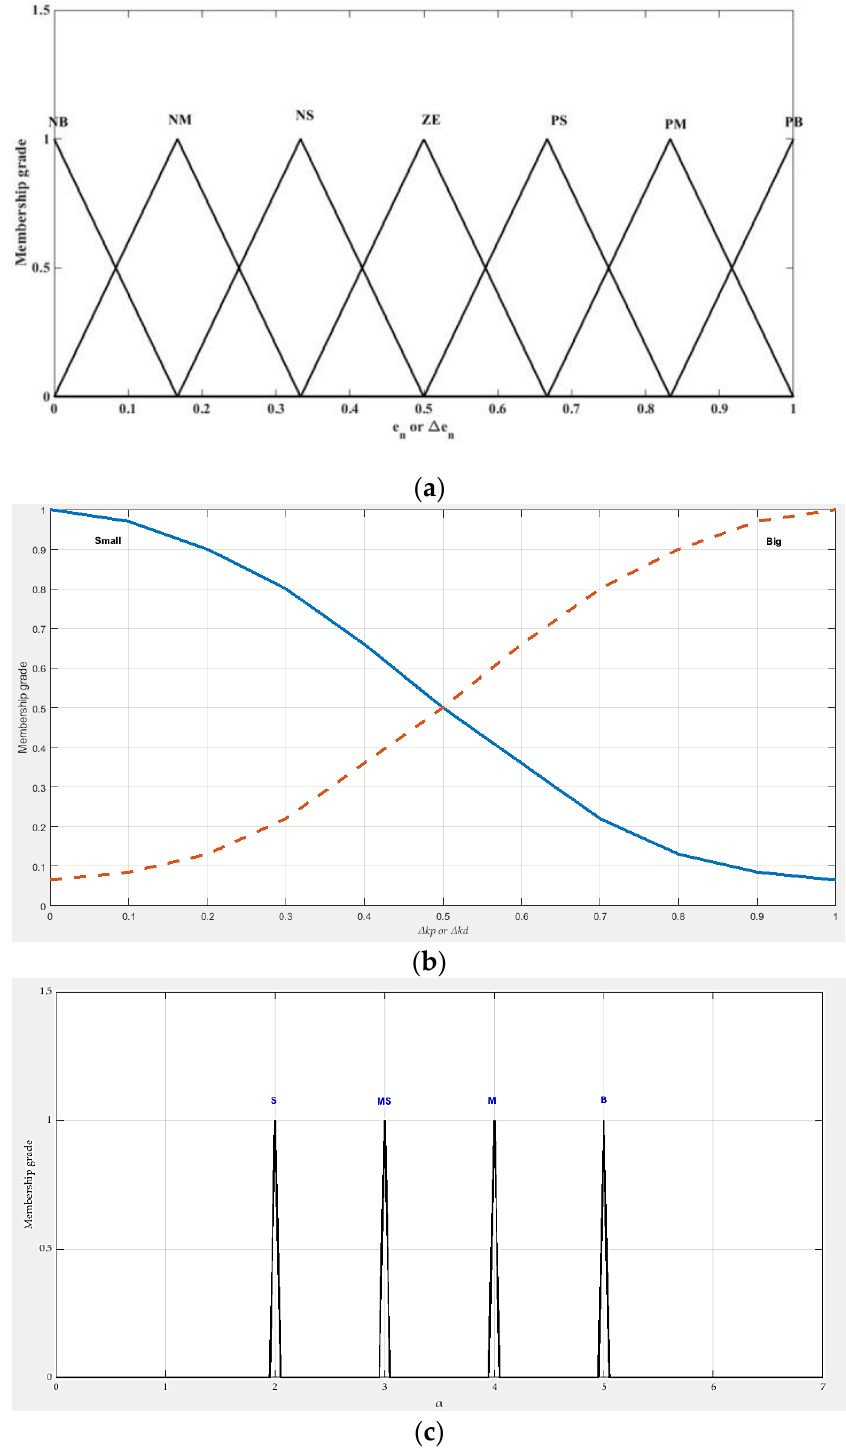
∆ e ∆ k ∆ k α n , n ), ( b ) ( p and d ), and ( c )